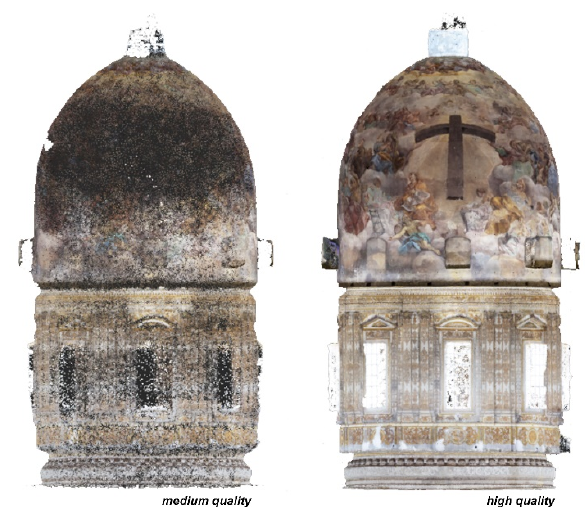
Figure 9. Image-based point cloud processed by the Parrot ANAFI dataset: detail of the dome obtained by the process in medium and high quality